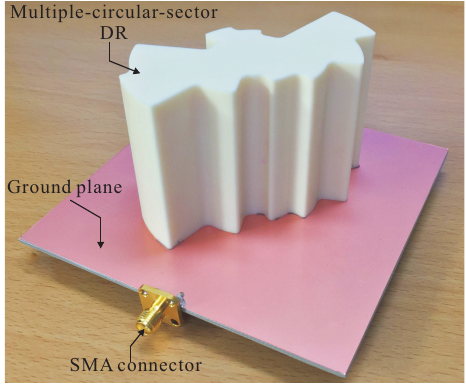
Figure 7. Photograph of the fabricated antenna.